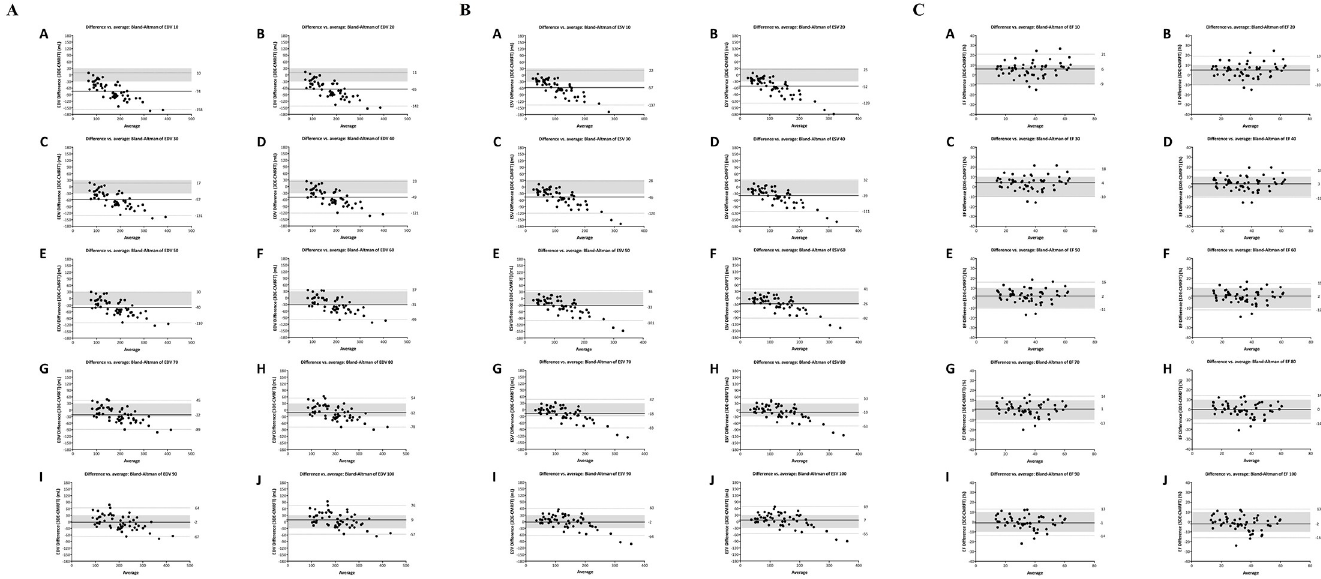
Fig 5. Bland-Altman analysis of left ventricular end-diastolic volume (Fig 5A), left ventricular end-systolic volume (Fig 5B), and left ventricular ejection fraction (Fig 5C) between cardiac magnetic resonance feature tracking method and 3D echocardiography with automated quantification software (Dynamic HeartModel) according to change in border setting from 10 to 100. A, border threshold of 10; B, border threshold of 20; C, border threshold of 30; D, border threshold of 40; E, border threshold of 50; F, border threshold of 60; G, border threshold of 70; H, border threshold of 80: I, border threshold of 90; J, border threshold of